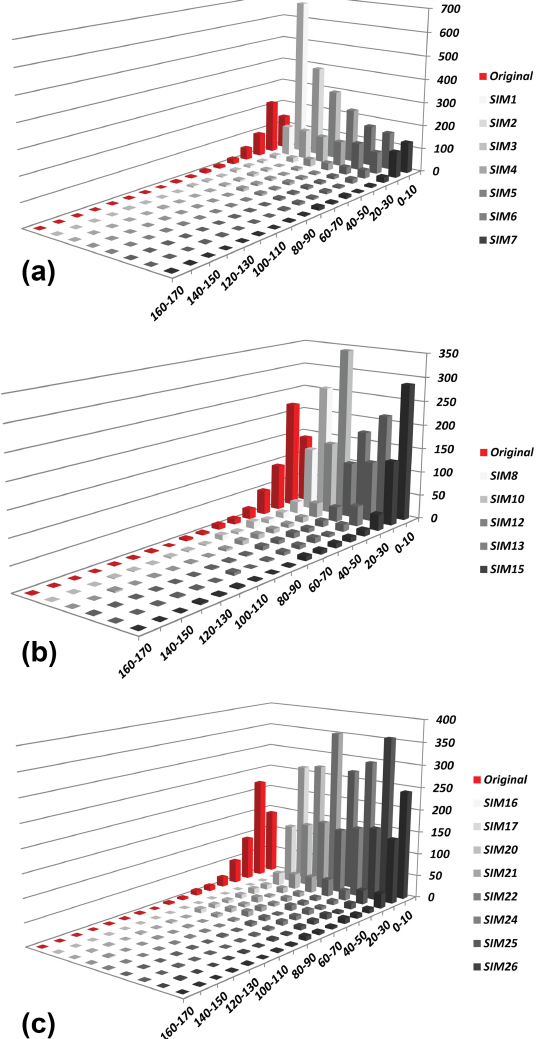
Figure 8. Fracture length distributions tested during the sensitivity analysis. (a) Fracture length distribution for SIM 1–SIM 7, (b) frac- ture length distribution for SIM 10, SIM 12, SIM 13 and SIM 15, and (c) fracture length distribution for SIM 16, SIM 17, SIM 20, SIM 21, SIM 22, SIM 24, SIM 5 and SIM 26. The x axis repre- sents the lengths of the classes of fracture in metres, and the y axis represents the number of fracture per length class.